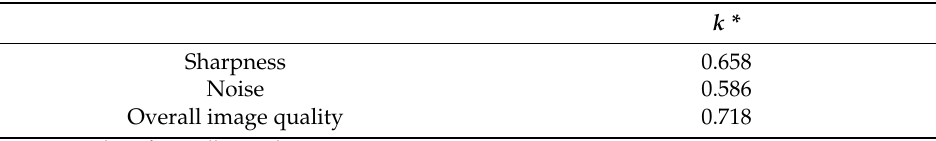
Table 4. Interobserver agreement for each variable.